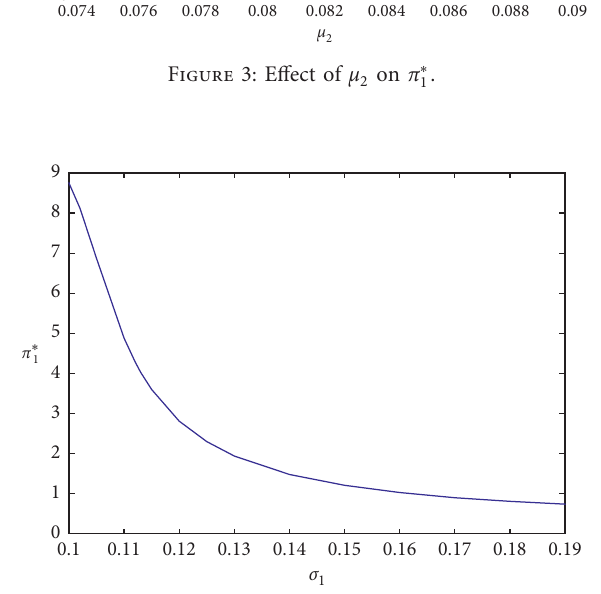
Figure 4: Effect of σ